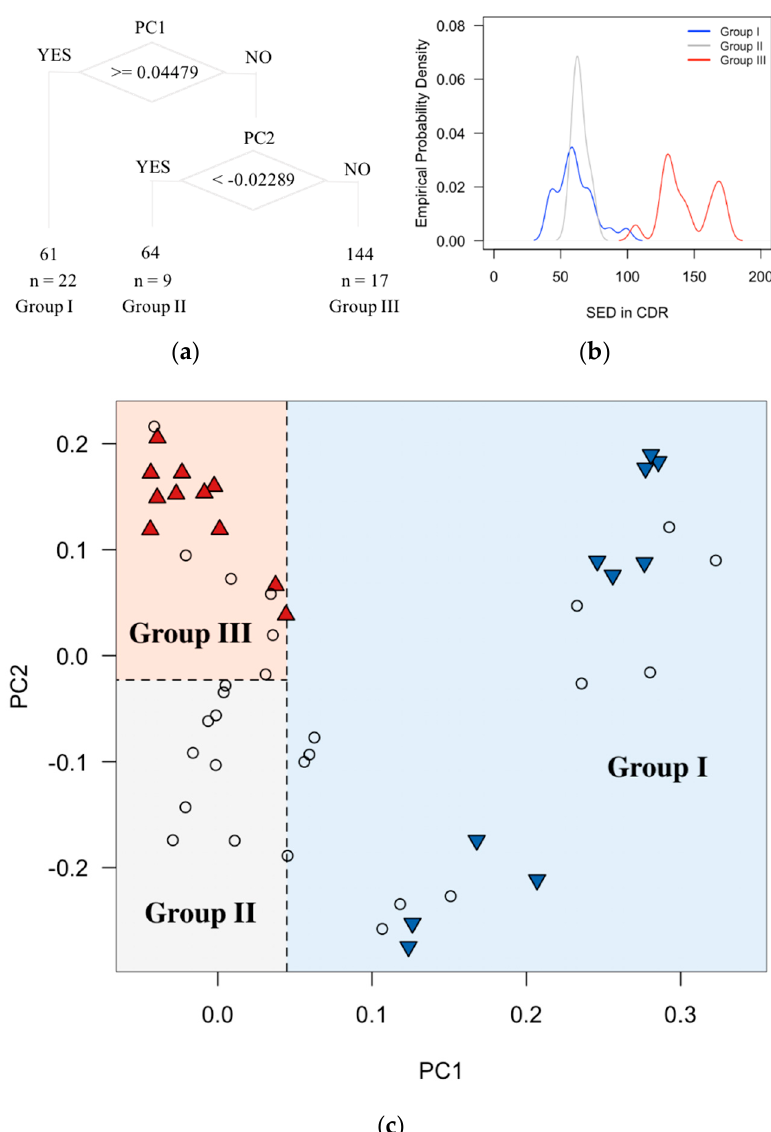
Figure 4. Classification of decadal spring extreme drought frequency in the core drought region based on ( a ) tree-based model; ( b ) probability density of each group; and ( c ) principal component 1 (PC1) and principal component 2 (PC2). Table 2. Explained variance of principal components (PCs) for decadal teleconnection indices.